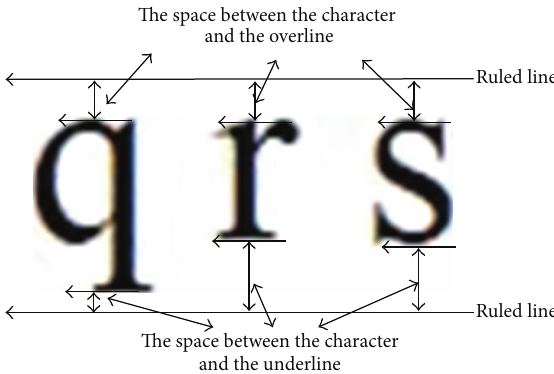
Figure 6: The space between the letter and the ruled lines.